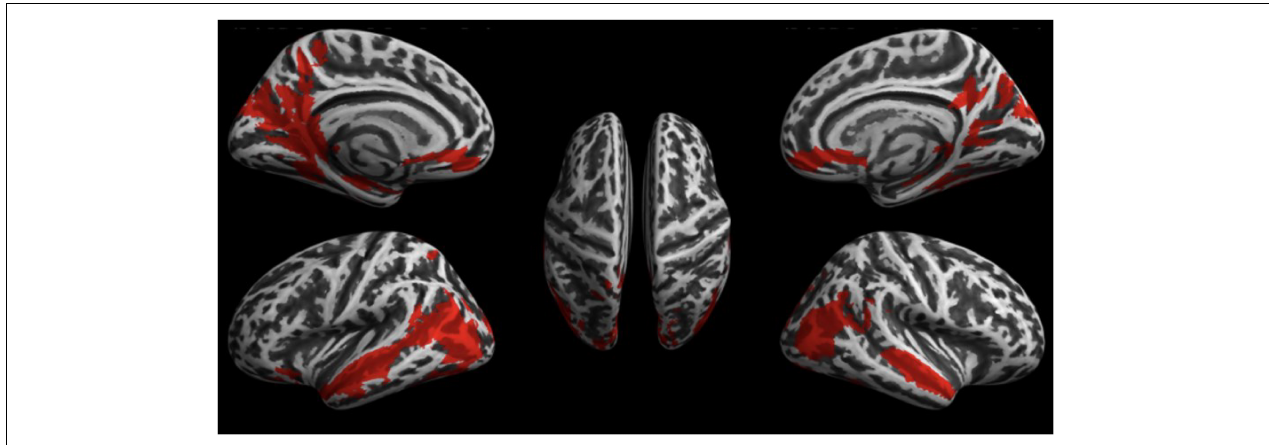
FIGURE 2 | Results of the fMRI Experiment 1: WN >